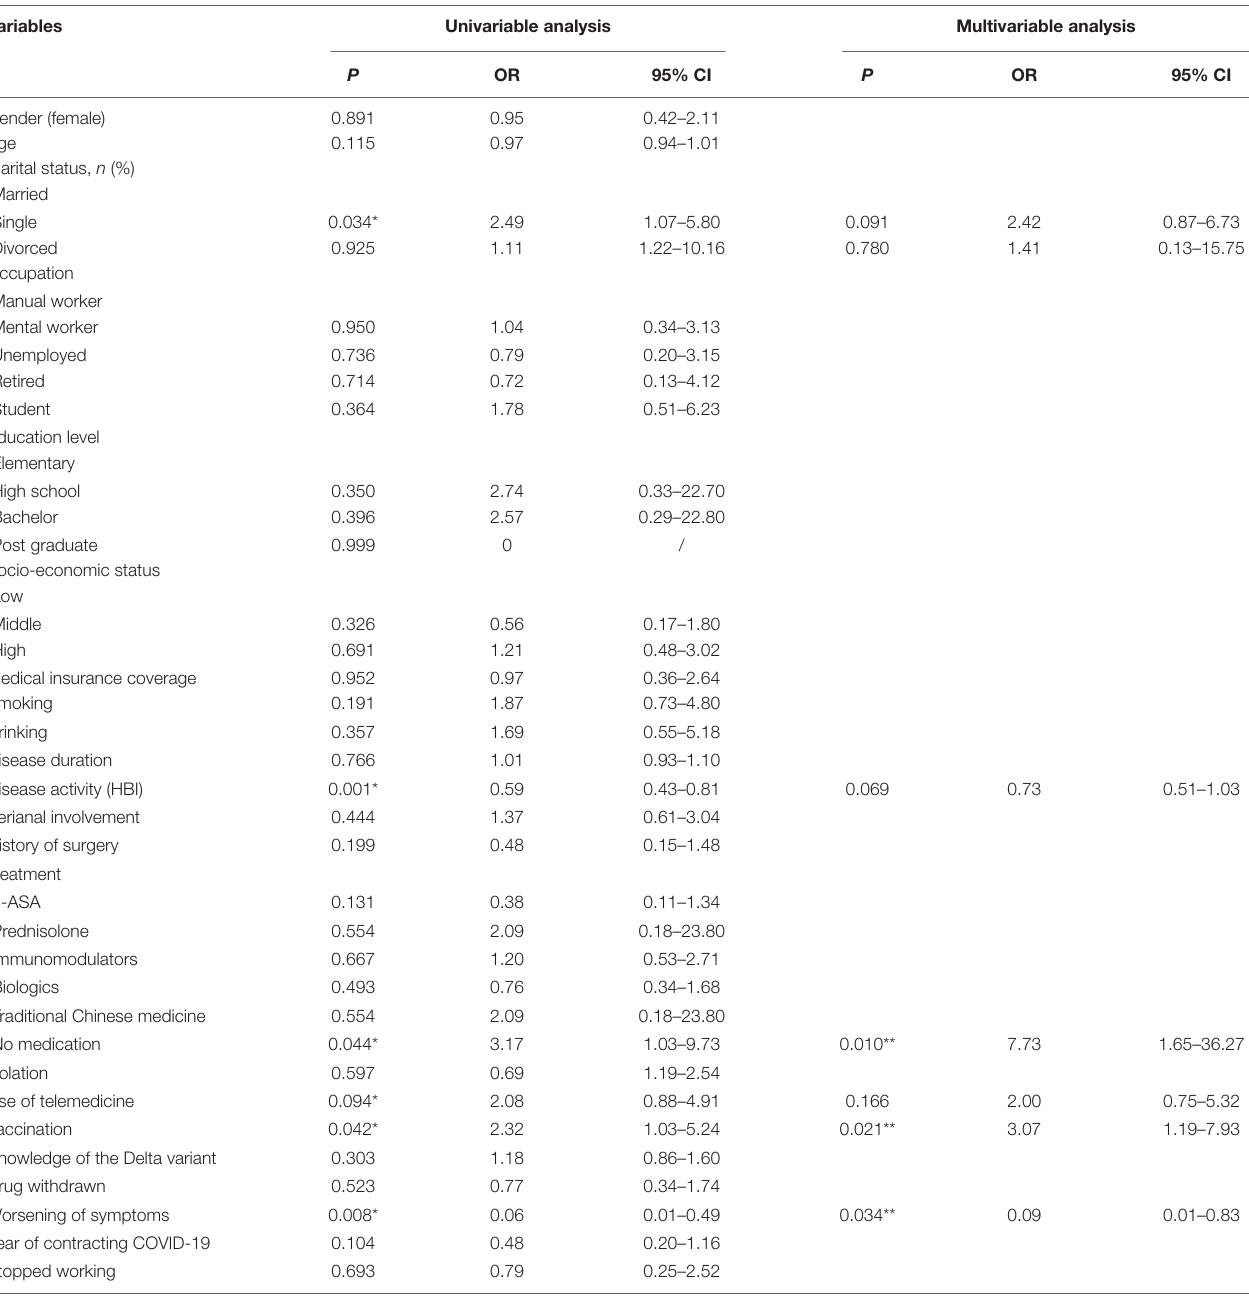
TABLE 6 | Factors associated with better life